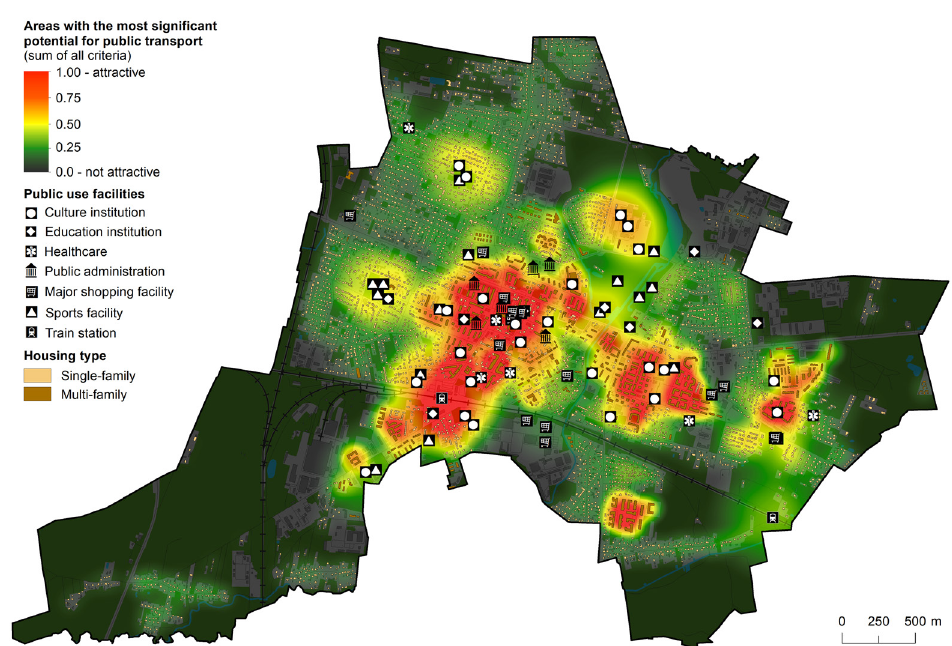
Fig. 9. Areas with the most significant potential for public transport (sum of all